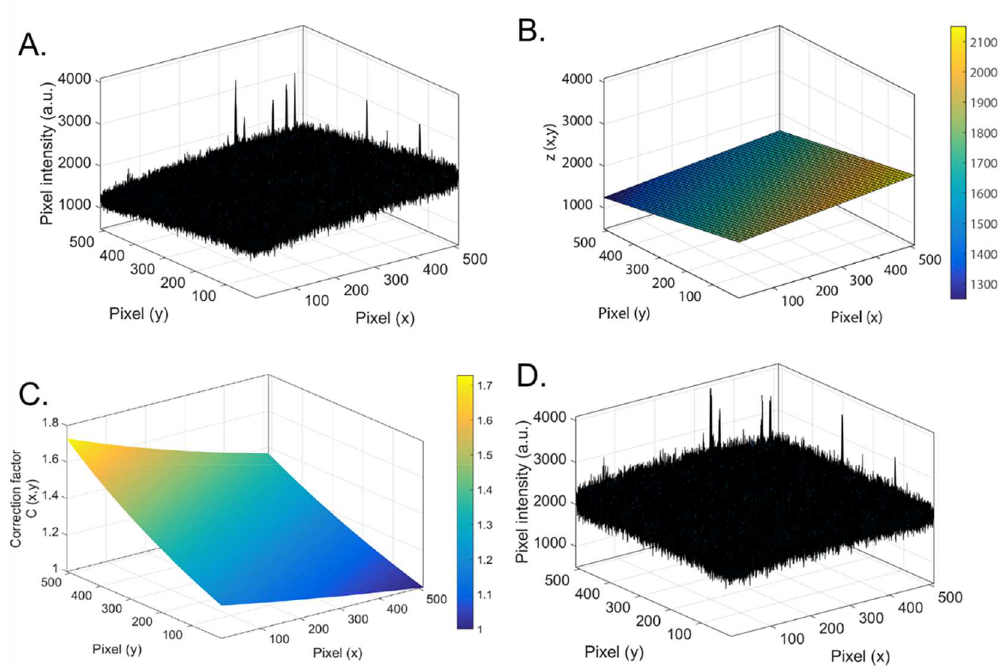
Fig 3. Correction for the effects of surfaceposition on the values of intensity. A) Three dimensional representation of raw pixel intensities from a confocalimage of a lipid bilayer on ox-PDMS. The x- and y-axis correspond to the pixel numbers whilethe z-axis correspondsto the intensity of the pixels. The image was 50.7 μ m × 50.7 μ m. It is clear that there are pixel-topixel variationsand a large-scalegradientthat makes the plane of intensity values appear‘tilted’. The tilt angle is relativelysmall ~ O (0.01) radians. Large peaks significantly above the mean fluctuationof the pixel intensities correspond to adsorbedSUVs. B) The result of a plane fit to the pixel intensities. The plane is a good representation of the position z(x , y) of the surface. C) A three-dimensional representation of the corresponding matrix of correction factors C(x , y) to account for the non-planarpositionof the substrate. D) The intensitiesafter multiplication with the correction factors, demonstrating the removalof the large- scale gradientdue to the varyingposition of the surface, while preserving the pixel-to-pixelfluctuations. S1